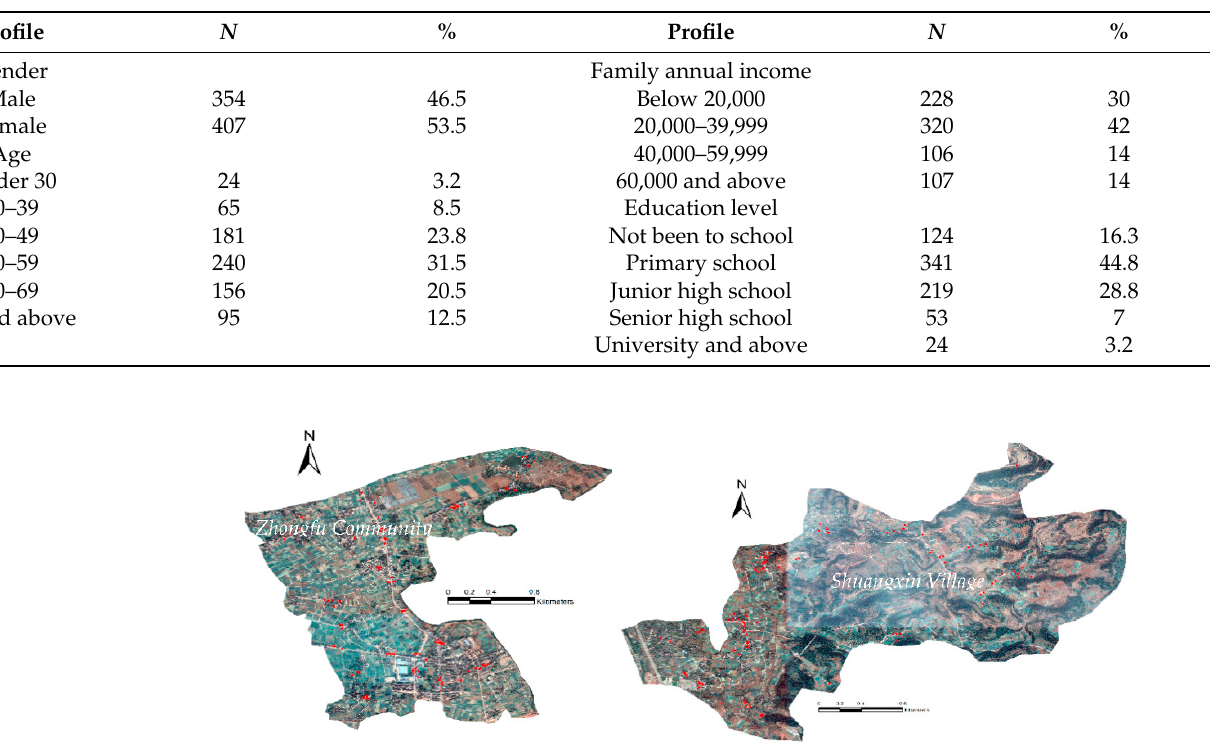
Figure 2. Location distribution map of respondents. 3.4. Statistical Tool SPSS24.0 (IBM, New York, NY, America) was used in this study to sort out the survey data and compare the differences in participation intention of respondents in straw recycling. Structural equation models are widely used to estimate direct and indirect causality between multiple variables [53]. Multiple group partial least squares structural equation model (PLS-SEM) of the software Smart PLS 3.3.3 (SmartPLS GmbH, Boenningstedt, Ahornstrasse, Germany) was used to fit the theoretical model. The structural equation model is developed on the basis of statistical theory, which is the comprehensive application and improvement of statistical methods such as exploratory factor analysis, confirmatory factor analysis, model path analysis, multiple regression analysis, and variance analysis. PLS-SEM can minimize the residual differences of endogenous variables and clarify the complex relationships among multiple variables at the same time. Compared with the covariance method, PLS-SEM is suitable for testing the significance of the hypothesis path because of its high prediction accuracy and low sensitivity to the normality problem [54]. In this study, the data were evaluated by external and internal measurements, followed by hypothesis testing [55]. The outer model